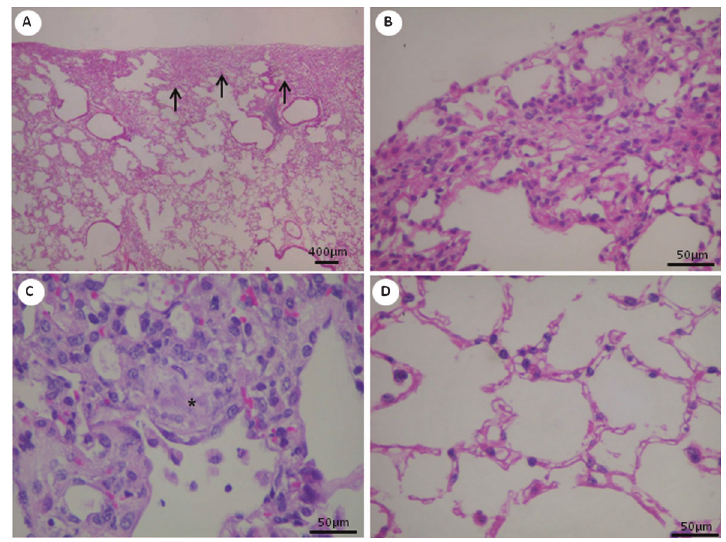
scarring areas of UIP compared with the control lung group (P=0.02, Figure 2D).